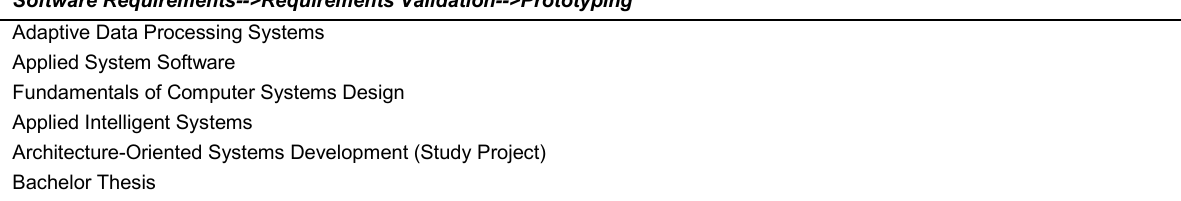
Table 4. Example of SWBOK concept "prototyping" correspondence to courses of curriculum "Computer